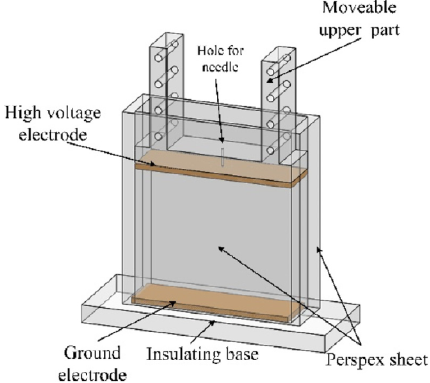
Figure 1. Schematic diagram of experimental cell.